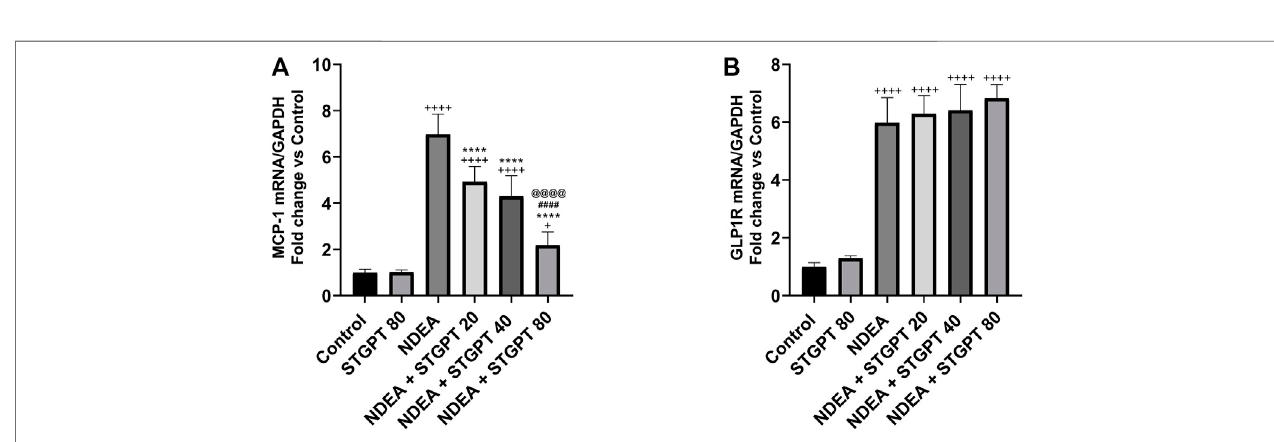
FIGURE 10 | Effect of STGPT (20, 40 and 80 mg/kg) on MCP-1 mRNA (A) and GLP-1R mRNA (B) in mice with NDEA-induced HCC. Data are presented as the mean ± SD( n (cid:1) 6). + p < 0.05 vs. Controlgroup, ++++ p < 0.0001 vs. Controlgroup,** p < 0.01 vs. NDEAgroup,**** p < 0.0001 vs. NDEAgroup, #### p < 0.0001 vs. STGPT 20 group, @@@@ p < 0.0001 vs. STGPT 40 group. Control, normal control group received the vehicle; STGPT 80, normal group received sitagliptin (80 mg/kg); NDEA, NDEA-induced HCC group received the vehicle; NDEA + STGPT 20, NDEA-induced HCC group treated with sitagliptin (20 mg/kg); NDEA + STGPT 40, NDEA- induced HCC group treated with sitagliptin (40 mg/kg); NDEA + STGPT 80, NDEA-induced HCC group treated with sitagliptin (80 mg/kg).